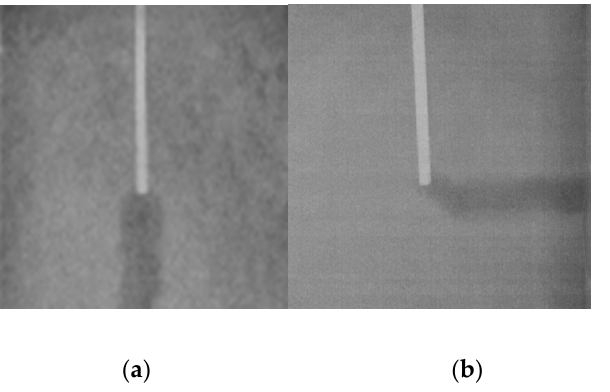
Figure 5. Image of the soil discharge channel of different soil resistivity: ( a ) ρ = 300 Ω ·m; ( b ) ρ = 700 Ω ·m.